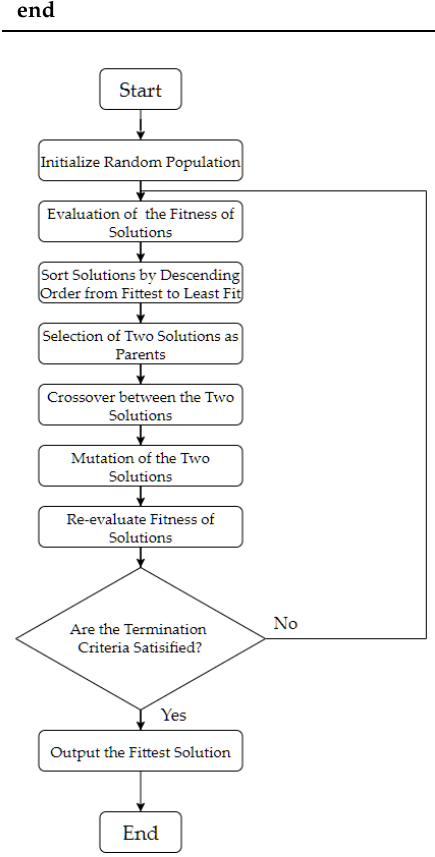
Figure 2. Flowchart of Genetic Algorithm.